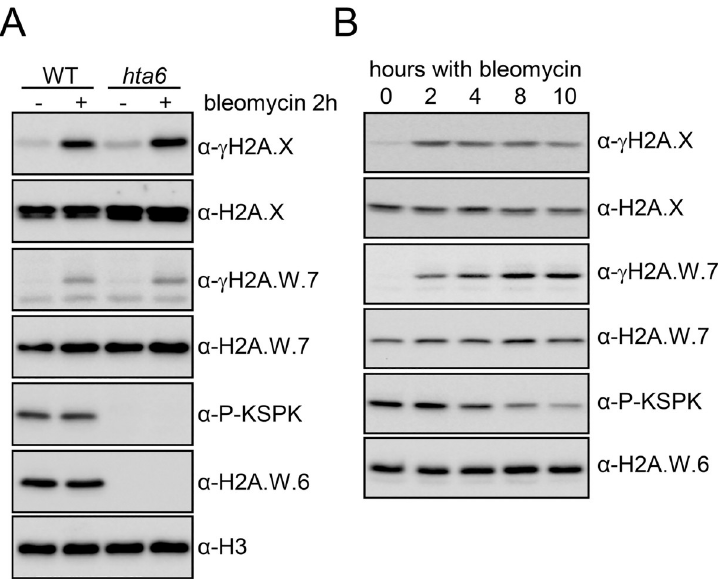
Fig 2. Phosphorylation of the H2A.W KSPK motif is not induced by DNA damage. (A) Phosphorylation of the KSPK motif on H2A.W.7 cannot be triggered by DNA damage. WT and hta6 mutant seedlings were either mock or bleomycin (20 μ g/ml) treated for two hours and nuclear extracts were analyzed by western blotting with indicated antibodies. (B) Arabidopsis WT seedlings were treated with 20 μ g/ml of bleomycin for the indicated time periods and protein extracts were analyzed with the indicated